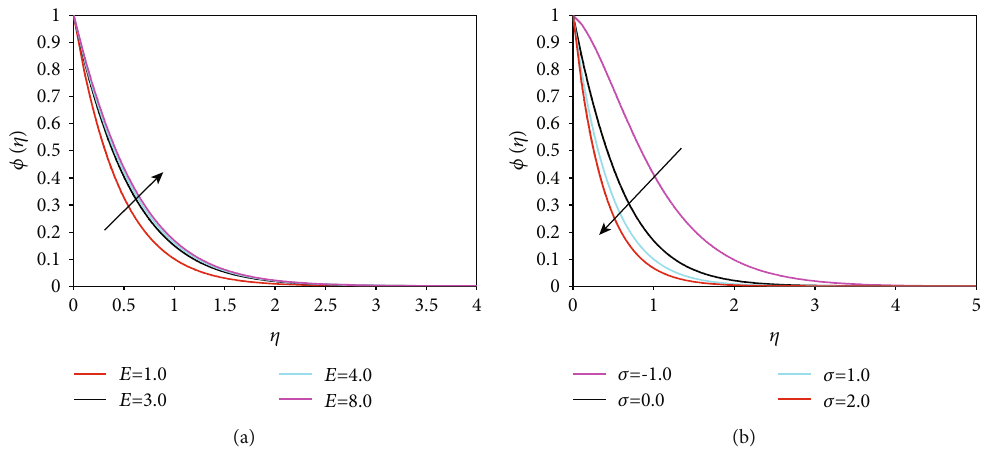
Figure 11: The graph of concentration for di ff erent values of activation energy ( E ) and reaction rate parameter σ .